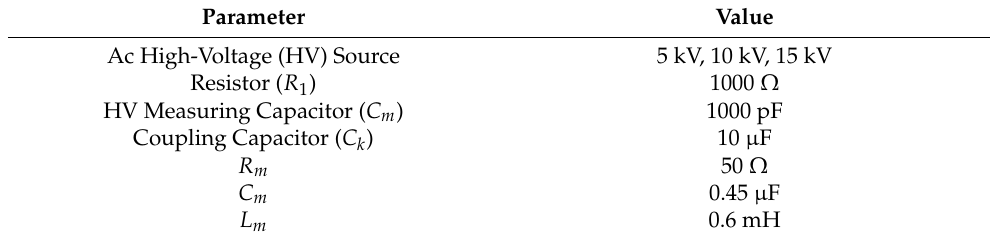
Figure 2. Capacitive model. Table 1. Capacitive Model’s